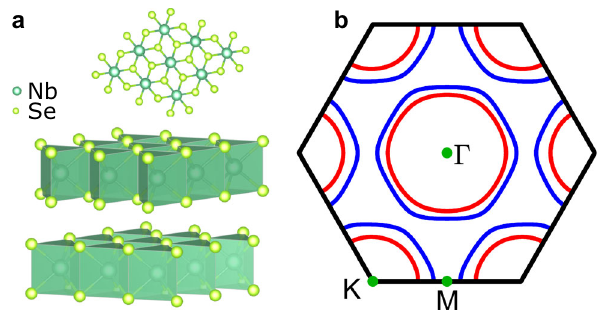
Fig. 1 Crystal structure and Fermi surface of NbSe 2 . a The three-fold symmetric crystal structure from top and side views 33 . b The Fermi surface has been calculated using a two-band tight-binding fi t to ARPES data 3 . Inner pockets (red) around Γ and K derive from one band, while the outer pockets (blue) derive from the second band; a small pancake-shaped pocket around Γ originating mainly from Se orbitals has been